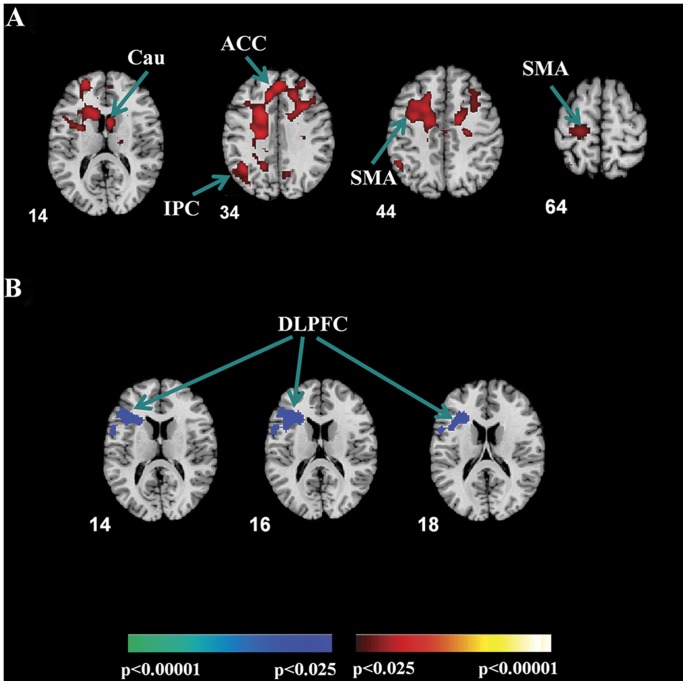
Activation Maps.(A) Representative axial–oblique slices depict greater activation of stutterers relative to healthy controls in frontostriatal regions when resolving Simon conflict (activation contrast: incongruent trials immediately preceded by a congruent trial versus congruent trials immediately preceded by a congruent trial). Abbreviations: ACC = anterior cingulate cortex; Cau = caudate; IPC = inferior parietal cortex; SMA = supplementary motor area. (B) Axial–oblique views of attenuated activation in the dorsolateral prefrontal cortex of stutterers as compared to healthy controls during response to incongruent trials under the influence of congruency of preceding trial (context-dependent adaptation, activation contrast: incongruent trials immediately preceded by an incongruent trial versus incongruent trials immediately preceded by a congruent trial). Abbreviations: DLPFC = dorsolateral prefrontal cortex. Statistical maps were displayed at a threshold of p<0.025 with a cluster extent of 30 voxels (P<0.05, corrected). The left-hand sides of the images correspond to the left side of the brain. The color bars indicate the t-values. The coordinates in Montreal Neurological Institute space are defined in millimeters.